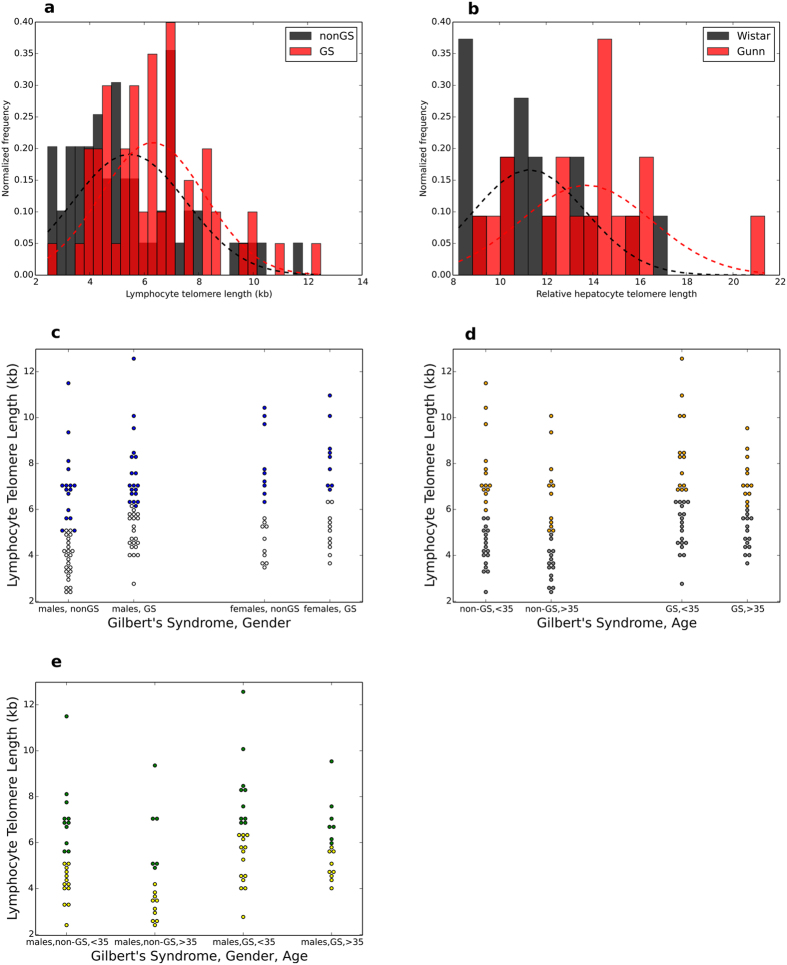
Telomere length distribution in human and animal samples.(a,b) Dark red bars represent frequency overlap between the groups. (c,d,e) Different colours represent values below and above the group mean (a) Distribution of absolute lymphocyte telomere length in Gilbert’s individuals; P = 0.01, Mann Whitney U test; P = 0.031, independent samples t-test, two-sided. (b) Distribution of relative liver telomere length in homozygous Gunn rats vs. heterozygous Wistar rats, P = 0.013, Mann Whitney U test; P = 0.01, independent samples t-test, two-sided. (c) Lymphocyte telomere length in GS and non-GS, age groups; P = 0.024, Kruskall-Wallis 1-way ANOVA; P = 0.053 for ≥35 years old GS vs. non-GS, independent samples t-test, two-sided. (d) Lymphocyte telomere length in GS and non-GS, gender; P = 0.013, Kruskall-Wallis 1-way ANOVA; P = 0.013 for GS males vs. non-GS males. (e) Lymphocyte telomere length in GS and non-GS, age groups, males only; P = 0.01, Kruskall-Wallis 1-way ANOVA; P = 0.02 for ≥35 years old GS vs. non-GS males, independent samples t-test, two-sided.